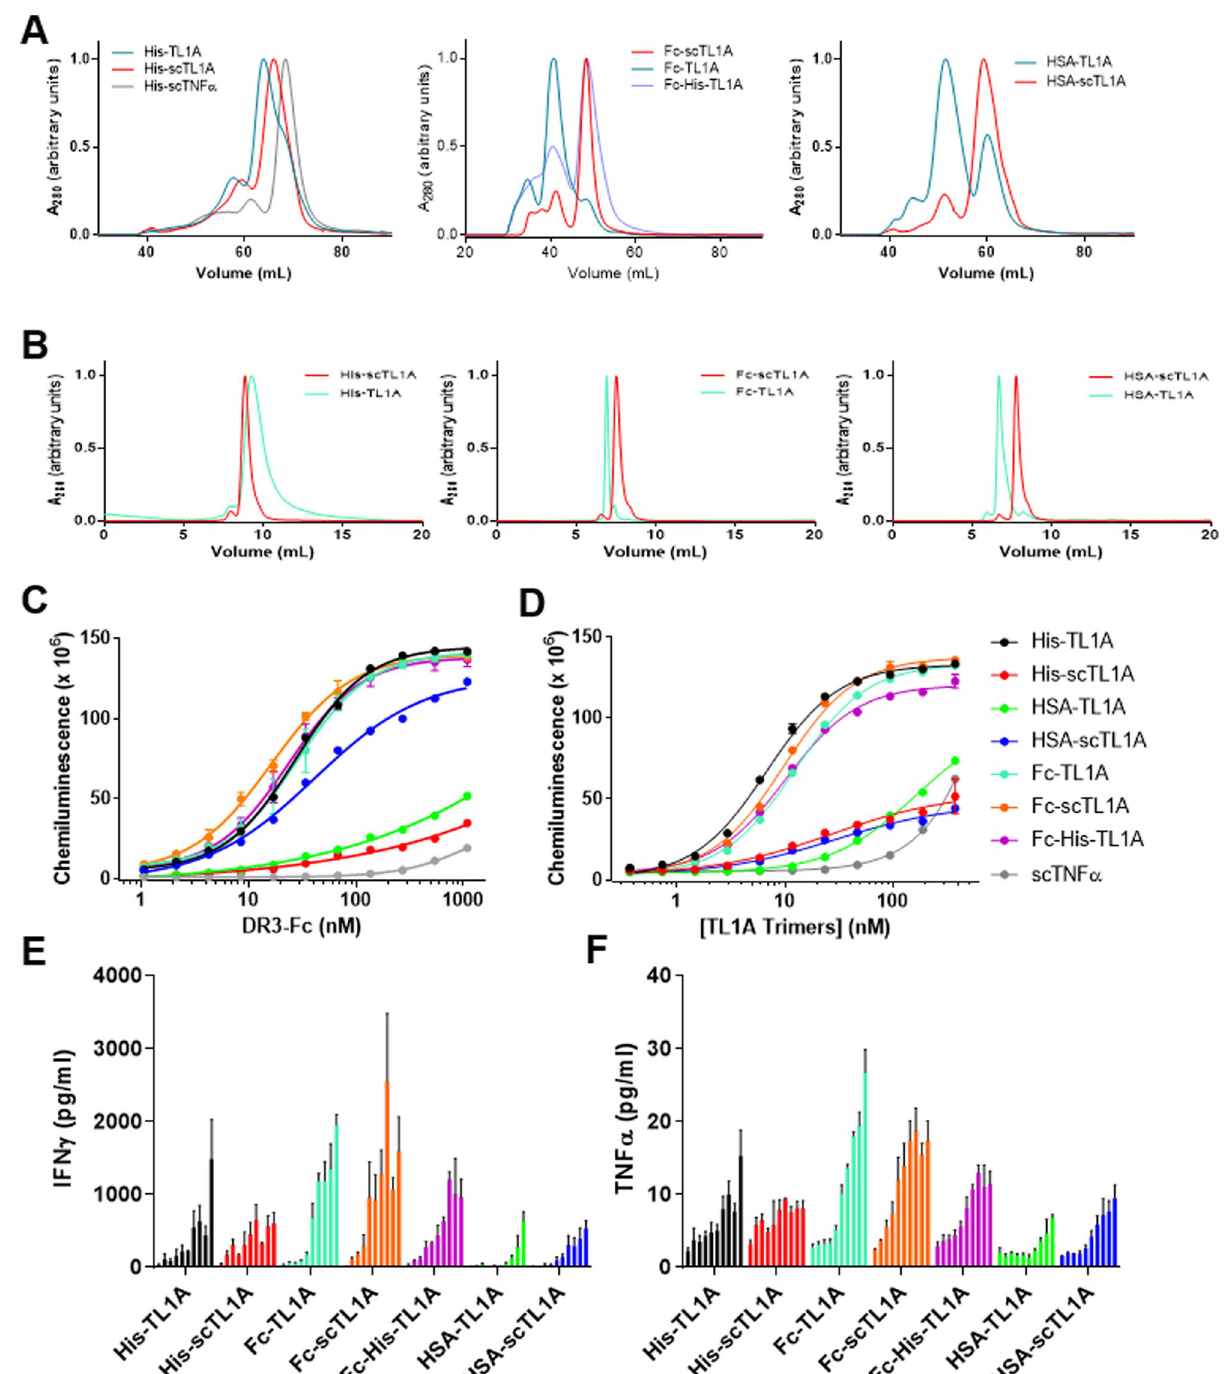
Figure 2. Fc-scTL1A Architecture Displayed High Monodispersity and Functional Activity. ( A ) Preparative gel- filtration analysis of TL1A constructs (indicated in legend). Recombinant TNFa was used as a control to show the population of trimer vs. oligomers. Main peaks in each chromatogram represent the target oligomeric species indicated in the main text. Off-target high molecular weight (HMW) oligomers and off-target low molecular weight (LMW) species are indicated in the chromatograms. ( B ) Analytical SEC analysis of TL1A constructs after preparative gel- filtration purification to isolate desired oligomeric species. The purified species were used in functional assays. ( C , D ) ELISA analysis of the ability of TL1A constructs to bind DR3 (left) or DcR3 (right). Molar concentrations of TL1A for each construct are normalized to concentration of TL1A trimers in each molecule. ( E , F ) Pan T cells from healthy donors were incubated with plate-bound anti-CD3 Ab (0.01 mg/mL). TL1A ligands at 0, 0.03, 0.1, 0.3, 1, 3, 10, 30 or 100 nM (trimer molarity) were added to aCD3-activated T cells. Levels of IFNg (left) and TNFa (right) produced by the activated T cells are shown. Stastical significance was determined using an unpaired T-test of unstimulated vs stimulated cells for each construct. Results represent averages from three independent experiments. Graphs were generated using Graphpad Prism (Version 9): https:// www. graph pad. com/ scien tific- softw are/